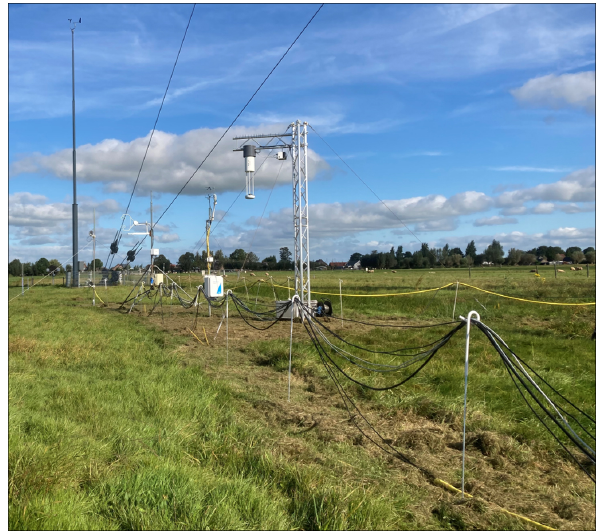
Figure 2. The instruments seen from the miniDOAS container look- ing north. From left to right: 10m wind gauge mast, mast with the two retroreflectors of the miniDOAS instruments, mast with sonic #3, mast with sonic #1 and LI-7500DS, mast with HT8700E and its cooling unit. Sonic#2 was placed later at 40cm on the southeast side of HT8700E on the same mast (not shown in the photo). The 213m mast is off to the right (east).